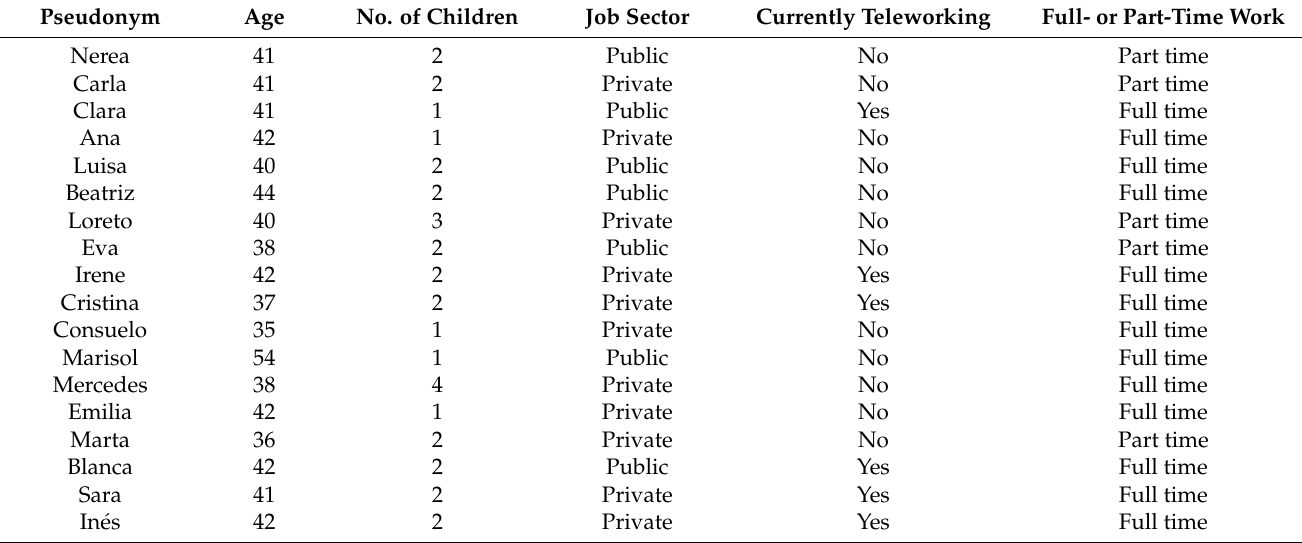
Table 1. Participants’ social and demographic characteristics.